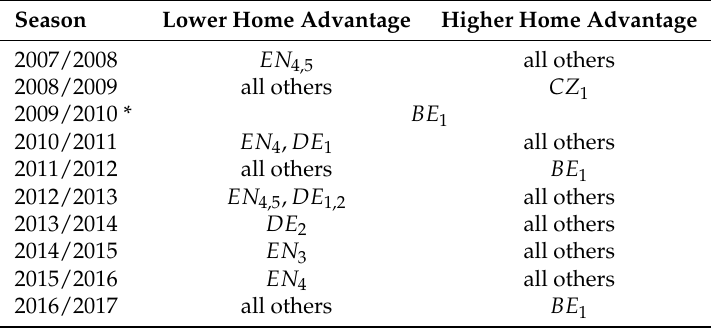
Table 7. Obtained components in seasons (based on χ 2